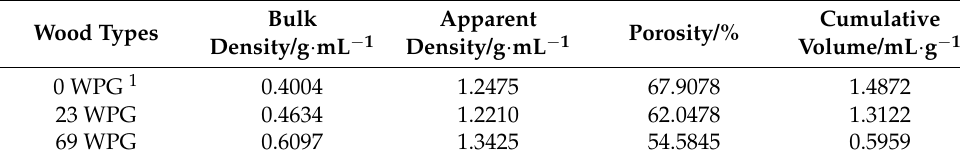
Table 1. Pore structure parameters by mercury intrusion porosimetry.